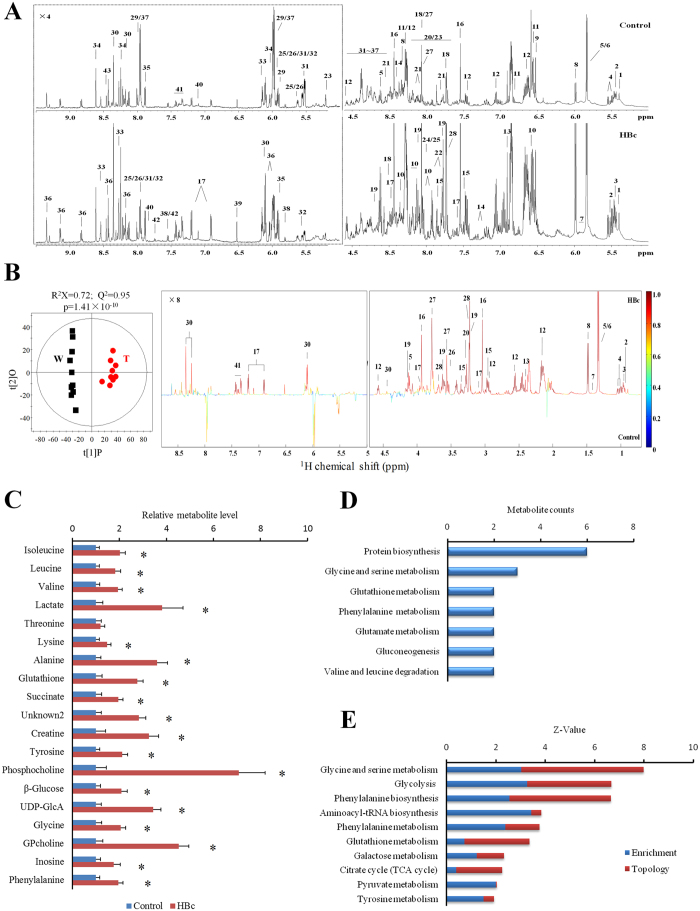
Metabolic characterization of HBc cells.(A) Average 600 MHz 1H HRMAS NMR spectra of HBc and control cells. The region of δ5.0–9.5 was vertically expanded 4 times compared with δ0.5–4.5. The metabolite list is shown in Table S2. (B) Validated OPLS-DA scores and coefficient plots show the discriminations of the metabolic profiles of extracts of HBc cells (T) from control cells (W). The resonance peaks pointing upward indicate an increase of metabolites in HBc cells and vice versa. The colour of the peaks represents the correlation coefficient of a metabolite where the cut-off value of |r| was 0.847 (n = 10, p < 0.001). The detailed data are shown in Table S2. (C) Metabolites consumed by HBc and control cells. The data are shown as the mean ± standard deviation (SD), n = 1 0, t test, *p < 0.001. Notes: UDP-GlcA, UDP-glucose A; GPcholine, glycerophosphocholine. (D) The enrichment analysis displays the metabolic pathways regulated by HBc. (E) The integrated metabolic pathways were obtained from metabolomics and proteomics analyses.